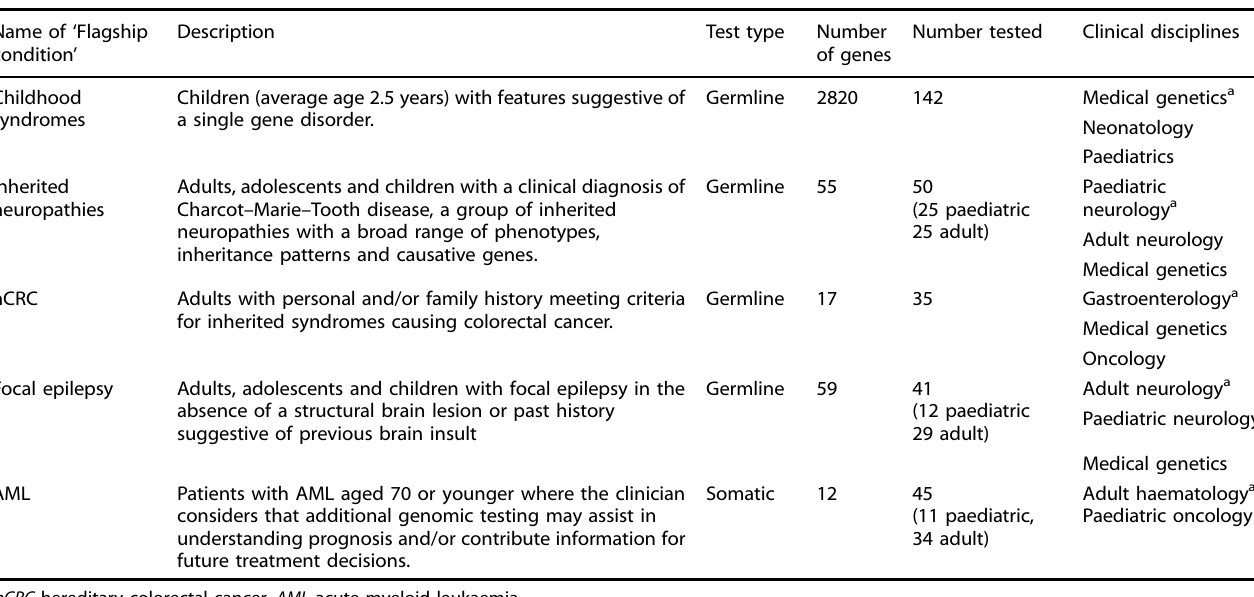
Table 2. Description of the Flagships Name of ‘ Flagship condition ’